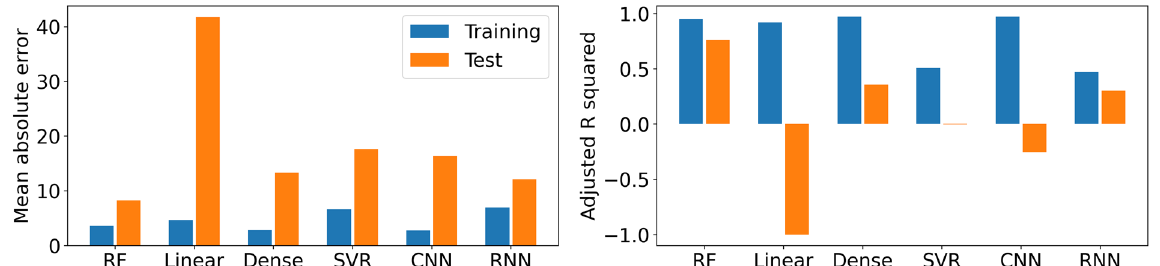
Figure 5. Comparison of model performance. The left panel shows the mean absolute error (MAE), and the 2 right panel shows the adjusted R . RF: Random Forest, Linear: least square Linear Regression, Dense: sequential model of three linear regression layers stacked, SVR: Support Vector Regression model, CNN: sequential model with a 1D Convolutional layer, RNN: sequential model with a long short-term memory